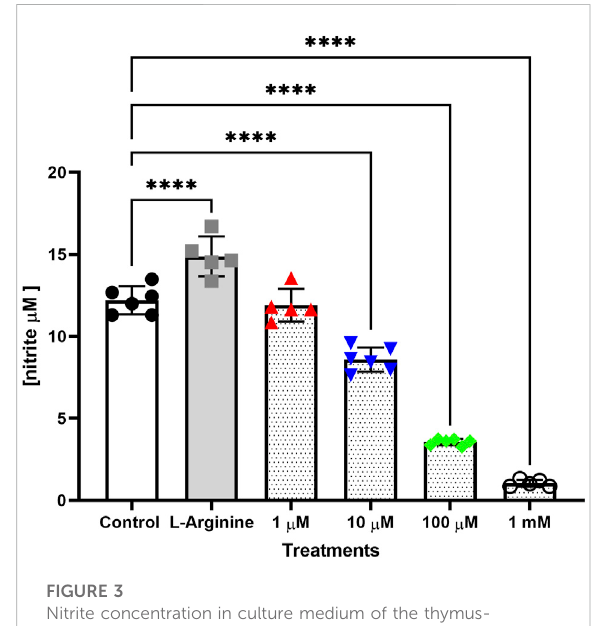
FIGURE 3 Nitrite concentration in culture medium of the thymus- derived endothelial cell line tEnd.1after treatment with